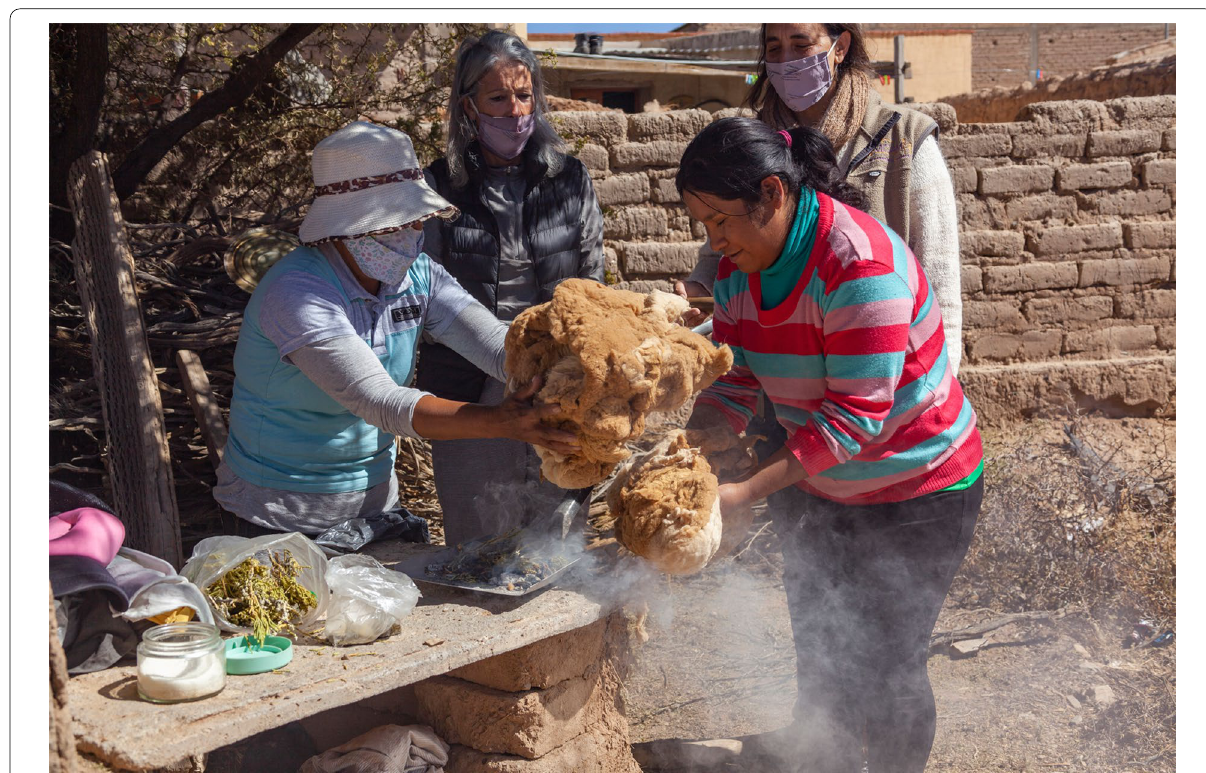
Fig. 1 Ceremony of the fibre smoking. From left to right: Norma Barconte, Bibiana Vilá, América Barconte and Yanina Arzamendia. Photo by Silvina